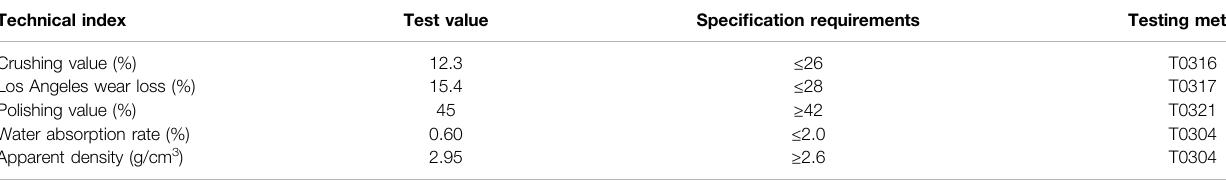
TABLE 1 | Basic performance test of aggregate.